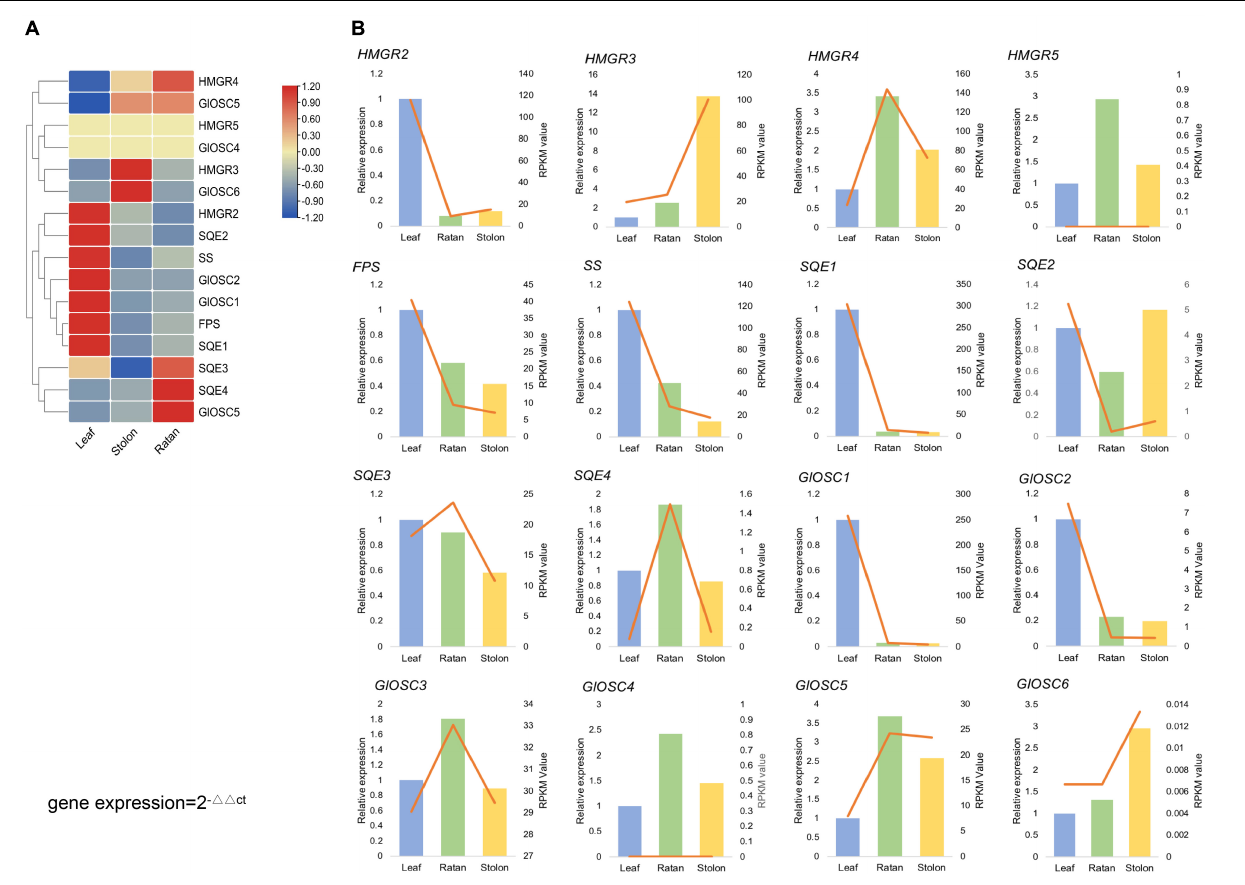
FIGURE 3 | (A) Expression analysis of the candidate genes, expression level of HMGR s, GlOSC s, SS s, FPS , SE in leaf, rattan and stolon of G. longipes. (B) Real-time quantitative polymerase chain reaction (PCR) validation of candidate unigenes involved in gypenosides biosynthesis by RNA-seq. The histogram indicated the relative gene gypenosides biosynthesis by RNA-seq, the right y -axis was gene expression level calculated as RPKM value, the left y -axis was relative gene expression obtained via real-time PCR. The relative expression obtained from real-time PCR calculated by 2 − (cid:49)(cid:49) Ct method.